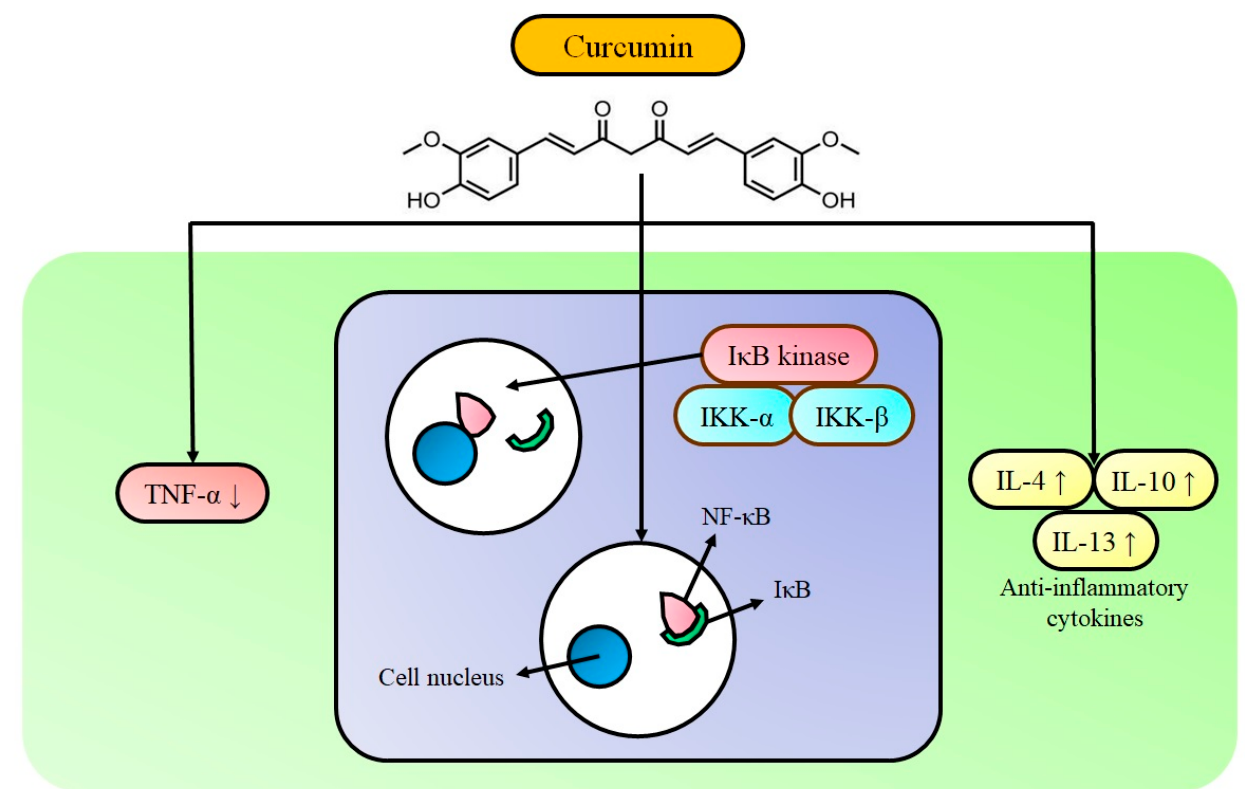
Figure 3. Curcumin’s activity against IBD: inhibition of the activation of NF- κ B, adapted from [75]. 4. Curcumin in Inflammatory Bowel Disease NF- κ B is a vital transcription factor associated with cytokine and chemokine produc- tion and is essential for inflammation. Therefore, many treatments used for IBD target NF- κ B. One study indicated that curcumin obstructed NF- κ B activation and decreased the mac- roscopic damage scores in a dinitrobenzene sulfonic acid (DNBS)-induced colitis model [82]. The curcumin’s effect was further confirmed by a decrease in myeloperoxidase activity, gene expression analysis, and a decline of the DNBS-induced message for IL-1 β . Further- more, curcumin decreased the reproducible dinitrobenzene (DNB)-induced p38 MAPK sig- nal activation in intestinal lysates [82]. Venkataranganna [83] posited that the curcumin’s inhibitory effect improves intestinal oxidative stress and reduces the expression of NF- κ B and iNOS, thus an improvement of colonic damage in 2,4-dinitrochlorobenzene (DNCB)- induced colitis rats was observed. This study revealed that an inhibitory effect of curcumin depends on the dosage. It protected DNCB-prompted changes in the colon length and body weight based on curcumin dose and increased the MPO, LPO, and ALP levels induced by DNCB. MAPKs, including p38 MAPKs and JNK, play a significant role in regulating the tran- scription of several genes associated with inflammation. To study the curcumin’s mecha- nism in chronic colitis rats, 50–100 mg/kg of curcumin was routed orally to a trinitroben- zene sulfonic acid (TNBS)-induced rat model daily for two weeks [84]. The experimental results revealed that curcumin effectively attenuated damage and activity of TNF- α and myeloperoxidase. Furthermore, it decreased the nitrite level and iNOS/COX-2 expression